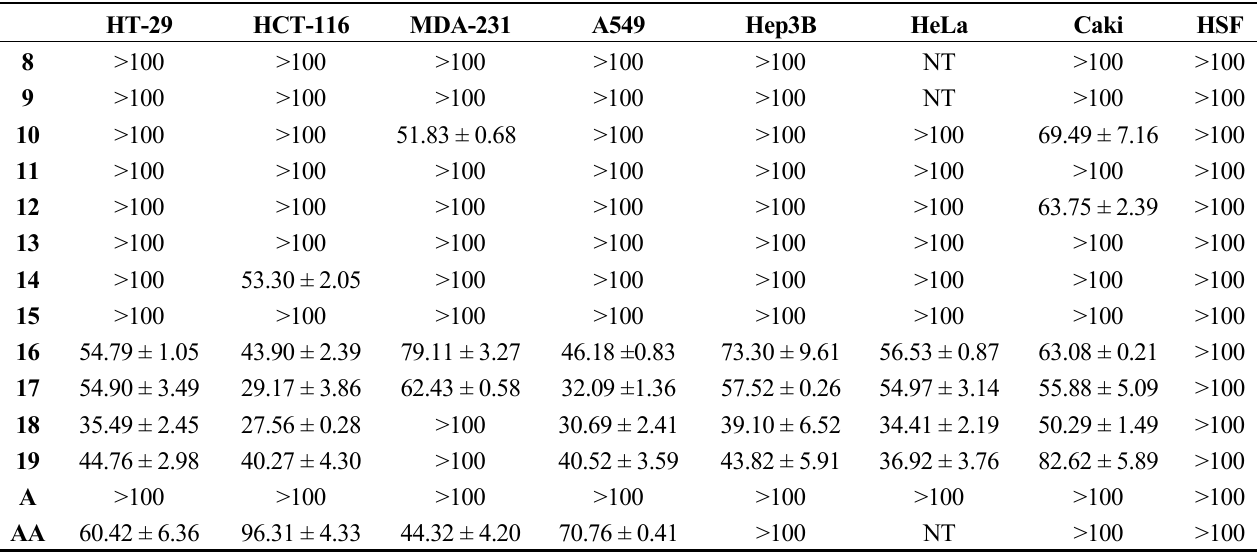
Table 1. IC values ( μ M) of synthesized compounds 8 – 19 against seven cancer cell lines a . 50